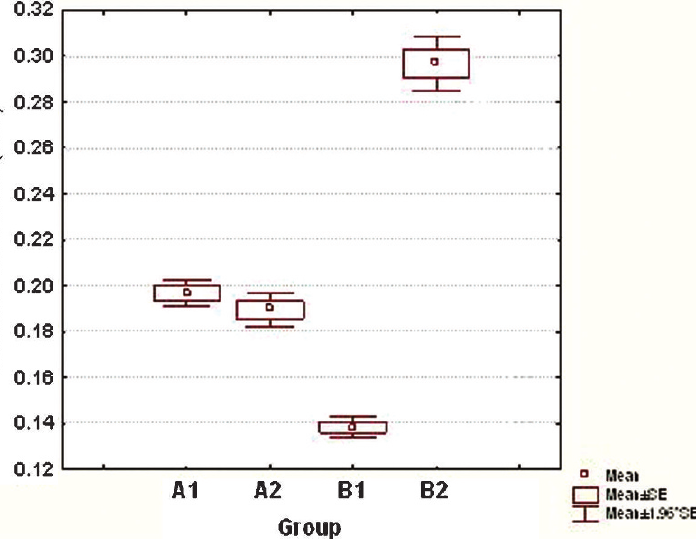
Figure 2 - Comparative box plots of the mean of mucosal thickness measures in control rats (A1), rats treated prophylactically using SCFAs (A2), control rats (B1), and rats treated with SCFAs (B2). No statistically significant difference between A1 and A2 was noted (p=0.1680). A statistically significant difference between B1 and B2 was observed (p=0.0001). SCFAs, short chain fatty